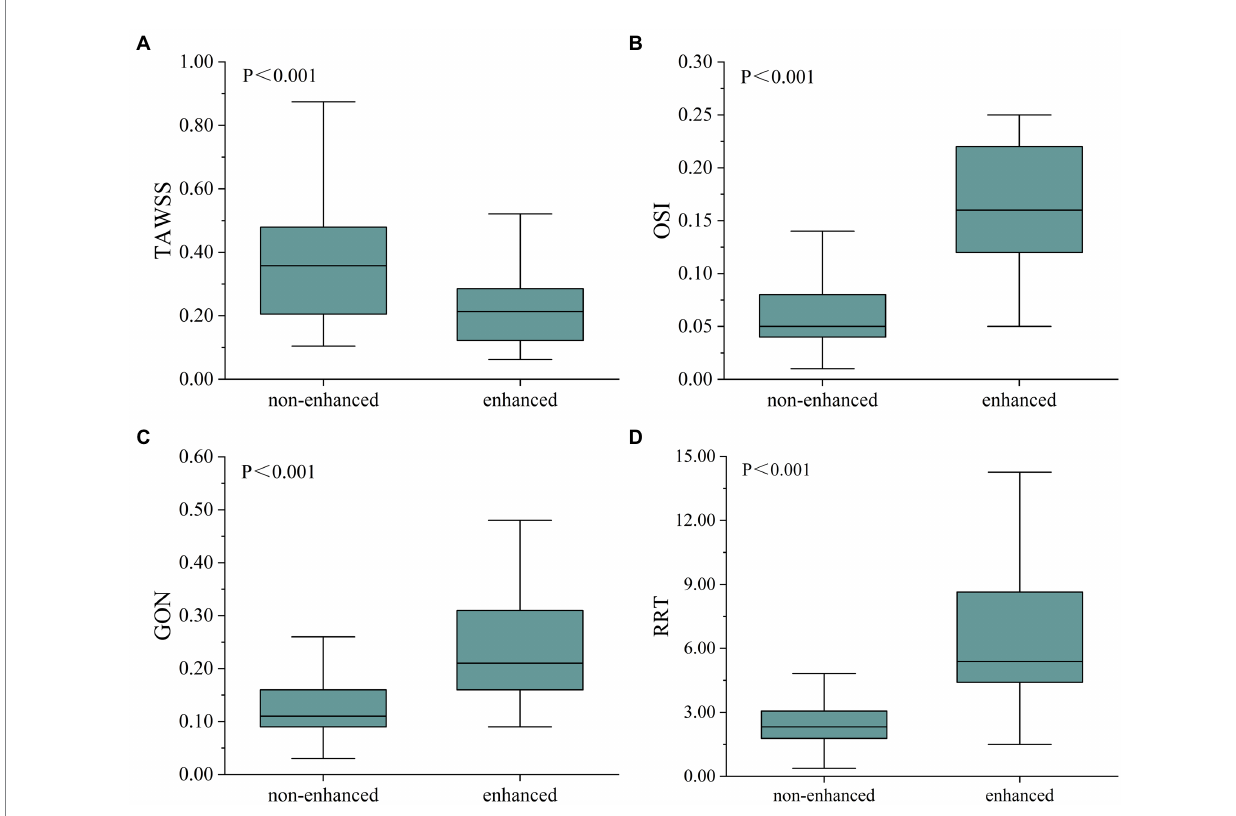
FIGURE 2 Box diagram showed the comparison of hemodynamic parameters between non-enhanced and enhanced regions. TAWSS was higher in the non- enhanced region (A) , whereas OSI (B) , GON (C) , and RRT (D) were higher in the enhanced region. TAWSS, time-averaged wall shear stress; OSI, oscillatory shear index; GON, gradient oscillatory number; and RRT, relative residence